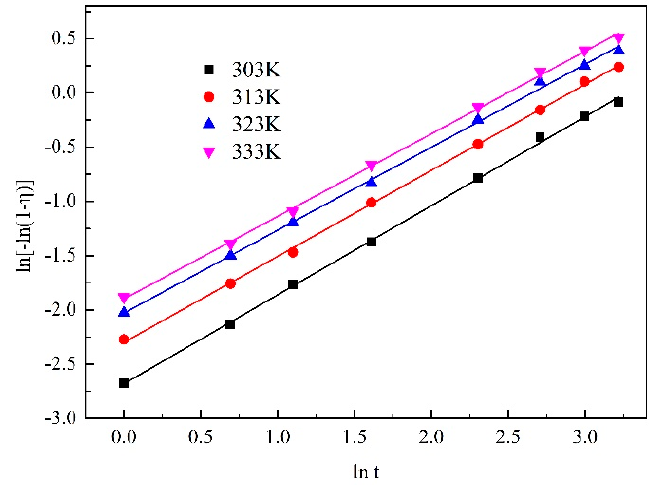
Figure 14. Plots of ln[ − ln(1 − η )] vs. lnt in alkali fused SCC leaching process under different temper- atures. Table 4. Fitting results between ln[ − ln(1 − η )] and lnt under different temperatures.